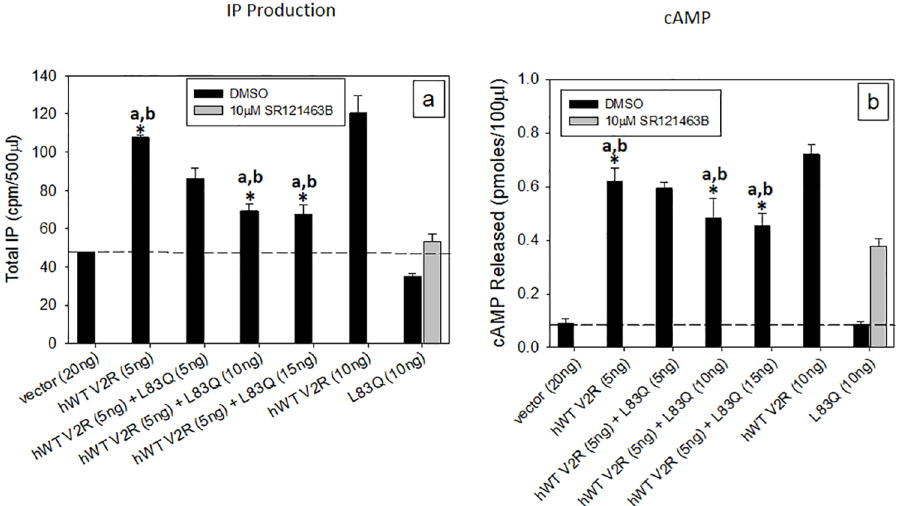
Fig 4. IP or cAMP production from HeLa cells transiently transfectedwith WT V2R in the presenceof increasing amounts of mutant. Cells were transiently transfected with an increasing amount of cDNA for the L83Q mutant in the presenceof hWT V2R, keepingthe WT at 5 ng and keepingthe total amount of cDNA at 20 ng by supplementing the difference with empty vector pcDNA3.1. The cells were stimulatedwith 1 μ M vasopressin and IP production(a) or cAMP (b) was measured. The dashedline shows the responseto the empty vector pcDNA3.1. The results shown in the figure are from at least 3 independentexperiments performed in quadruplicate(n = 3 ± SEM), p values < 0.05 is considered significant. * a, p < 0.05 compared with vector and WT V2R IP or cAMP production, * b, p < 0.05 comparedwith WT V2R and WT V2R + L83Q (10 and 15ng) IP or cAMP